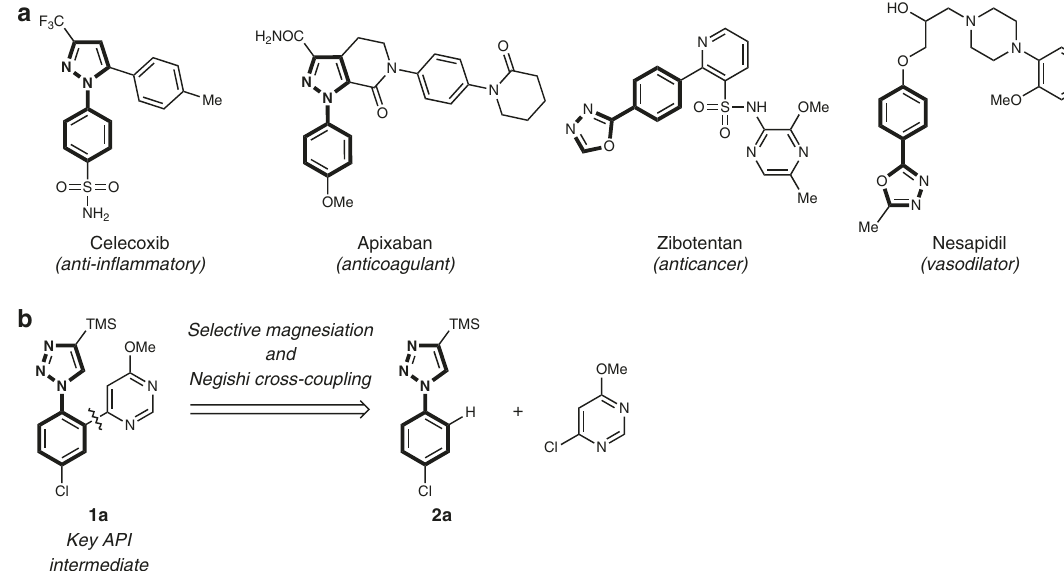
Fig. 1 Background and objective. a Examples of bioactive aryl azole derivatives. b Retrosynthetic strategy for API intermediate 1a